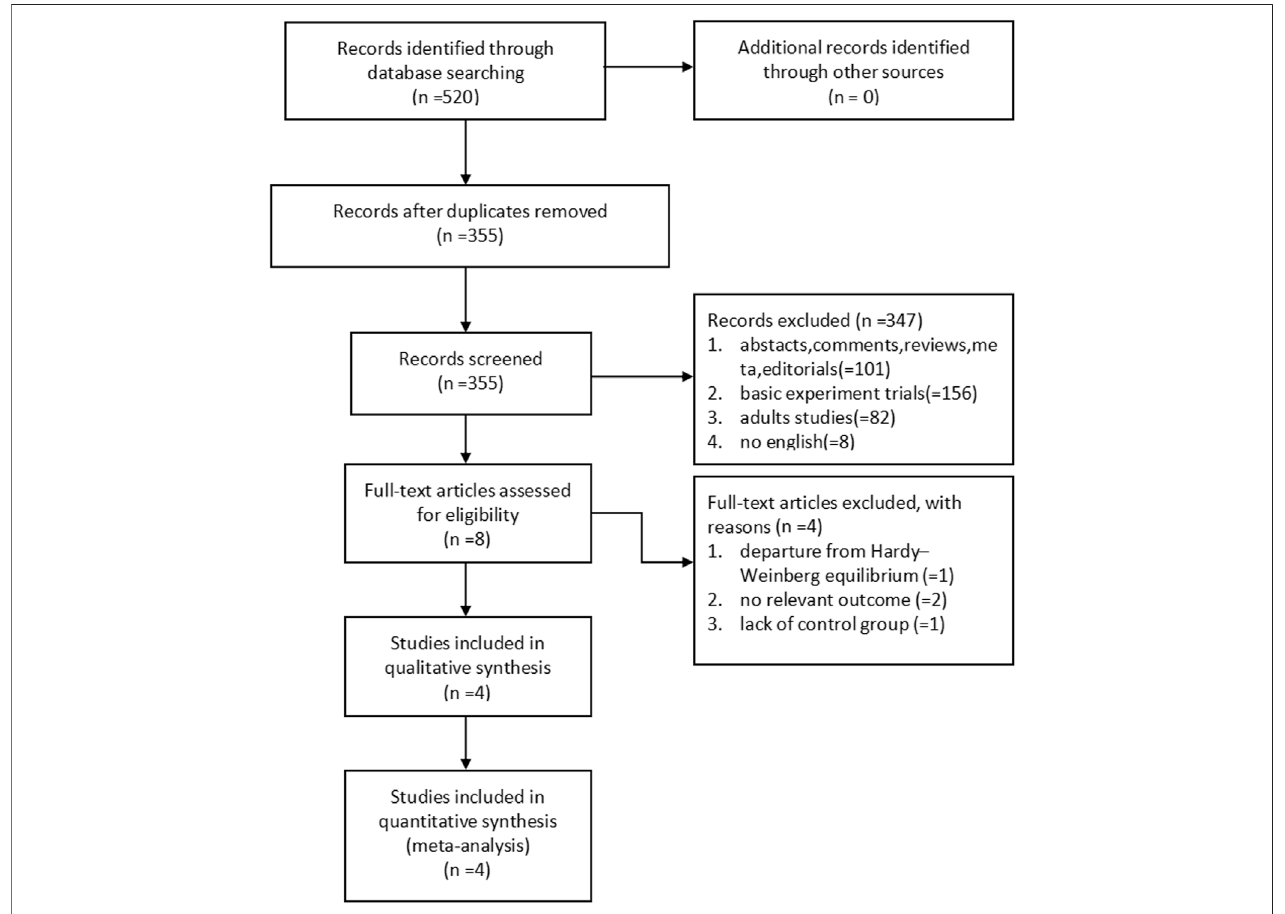
FIGURE 1 | Flow chart of literature